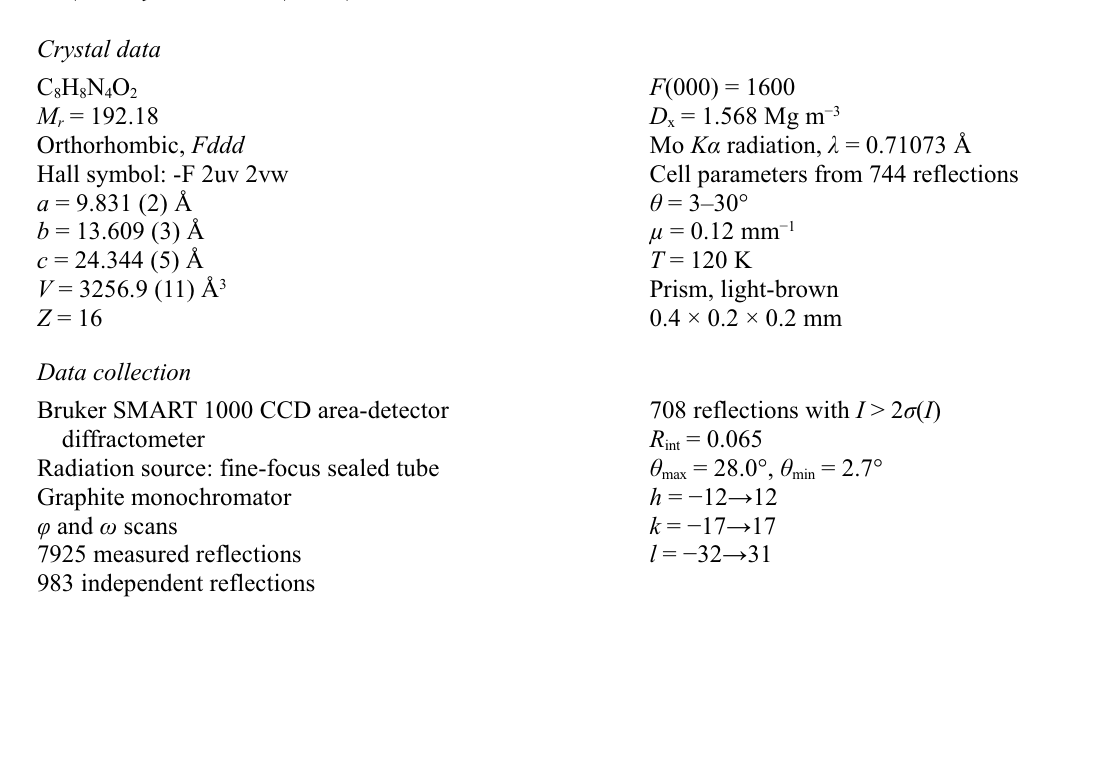
Figure 2 A packing diagram of the title molecule. Hydrogen bonds are shown as dashed lines. (2 Z ,3 Z )-Quinoxaline-2,3(1 H ,4H)-dione